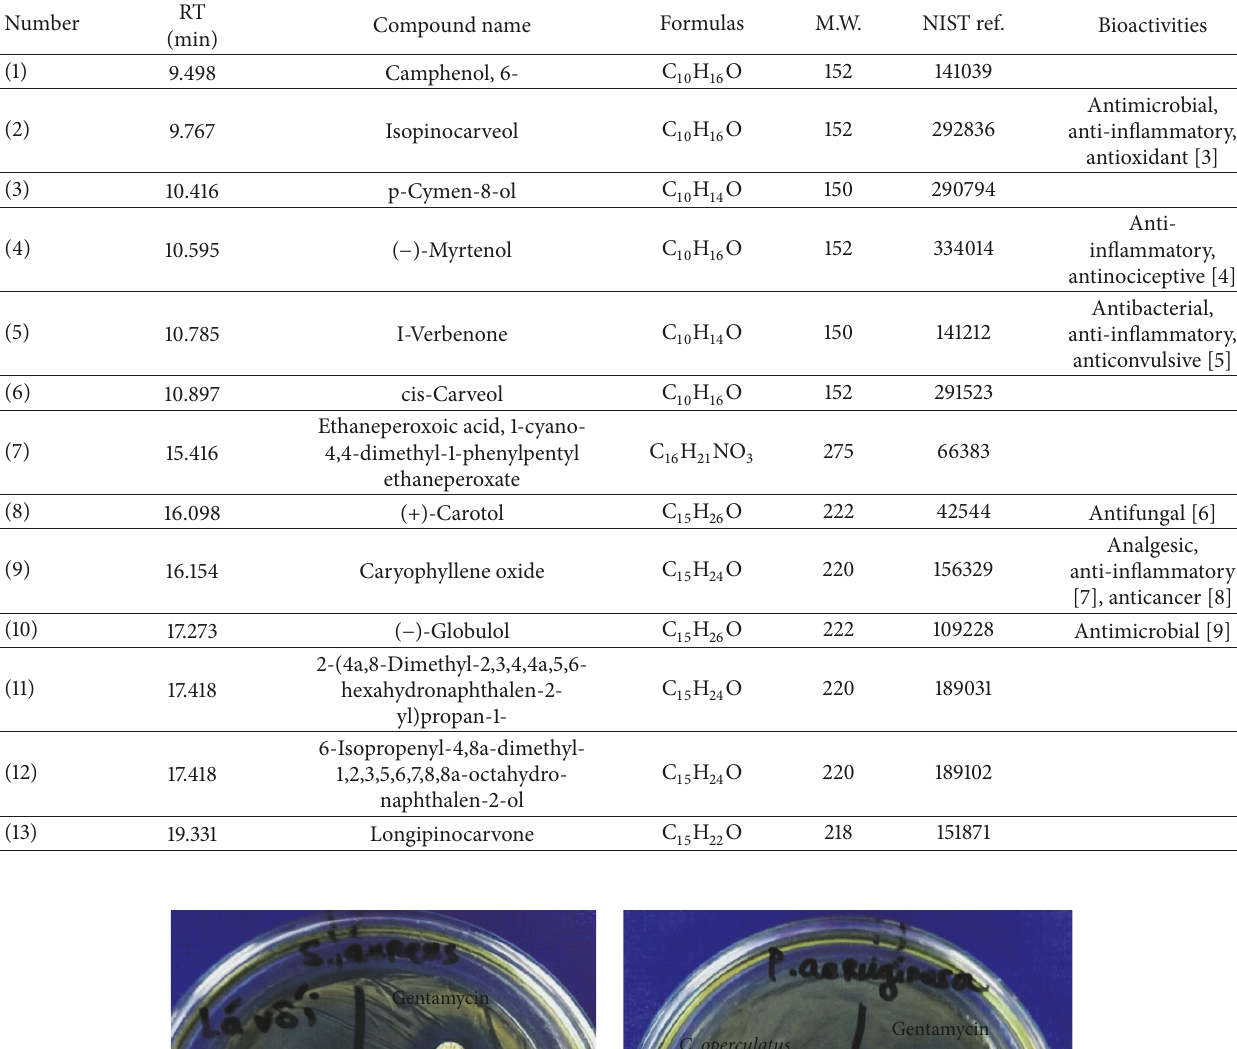
Table 1: Identification of some bioactive compounds in essential oil of Cleistocalyx operculatus leaves.